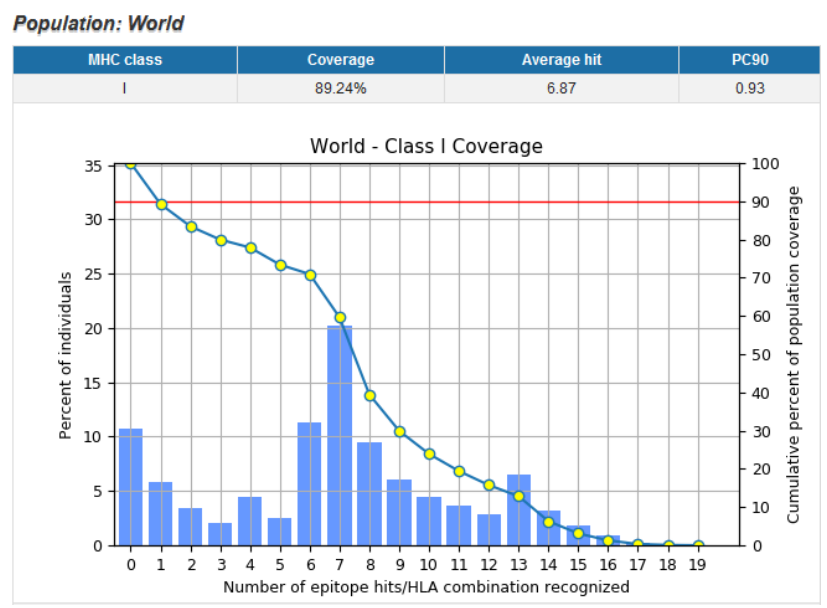
Figure 6. Population coverage graph for world population. The top epitopes demonstrate 89.24% population coverage when filtered for IFNγ release. The pc90 indicates the minimum number of hits required to obtain 90% coverage, which indicates that potential optimization of the top epitope list is possible. Retrieved from IEDB, “tools.iedb.org/population” (accessed on 24 September 2021). Table 3. Population coverage for regions of the